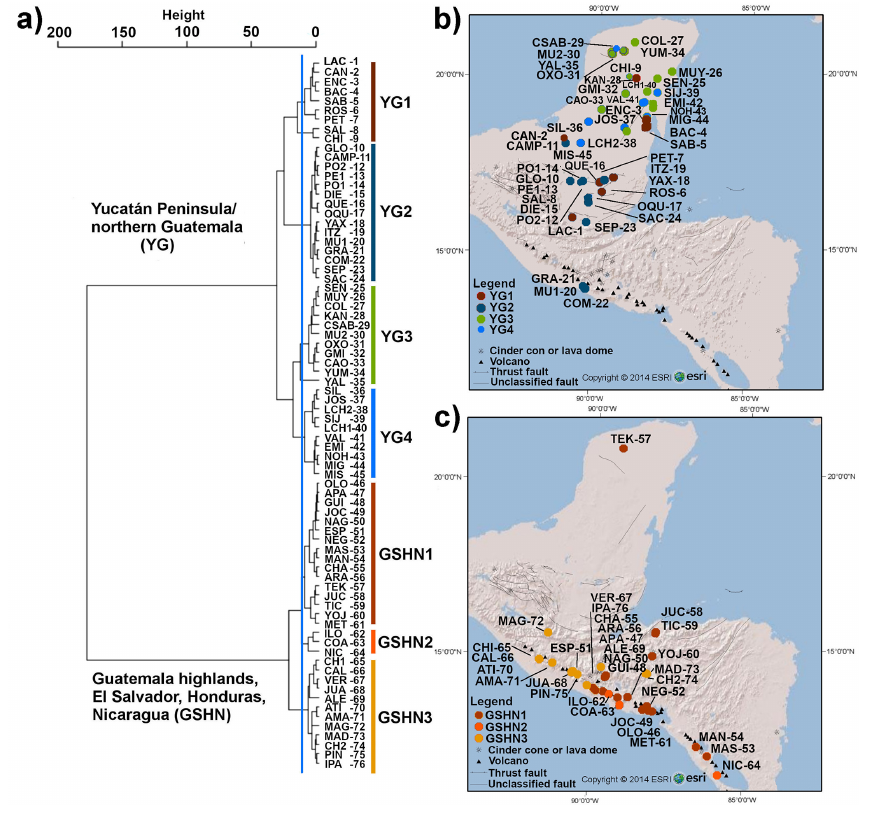
Figure 2. (a) Cluster analysis dendrogram of the 76 studied aquatic ecosystems using 23 water physicochemical, sediment geochemistry, mineralogical, and geological variables. Blue line indicates cut-off criterion for cluster partition. Two major groups and seven subgroups were detected and named according to their position in the study area: Yucatán Peninsula/Northern Guatemala (YG) and Guatemala highlands, El Salvador, Honduras, Nicaragua (GSHN). In order to provide a graphic representation of cluster grouping, a color bar was assigned to each group and lakes within these groups were plotted on the (b) YG map and (c) GSHN map using the same color. Full lake name codes presented in cluster and maps are given in Table S1. Numbers of lake name codes correspond to that in Fig.